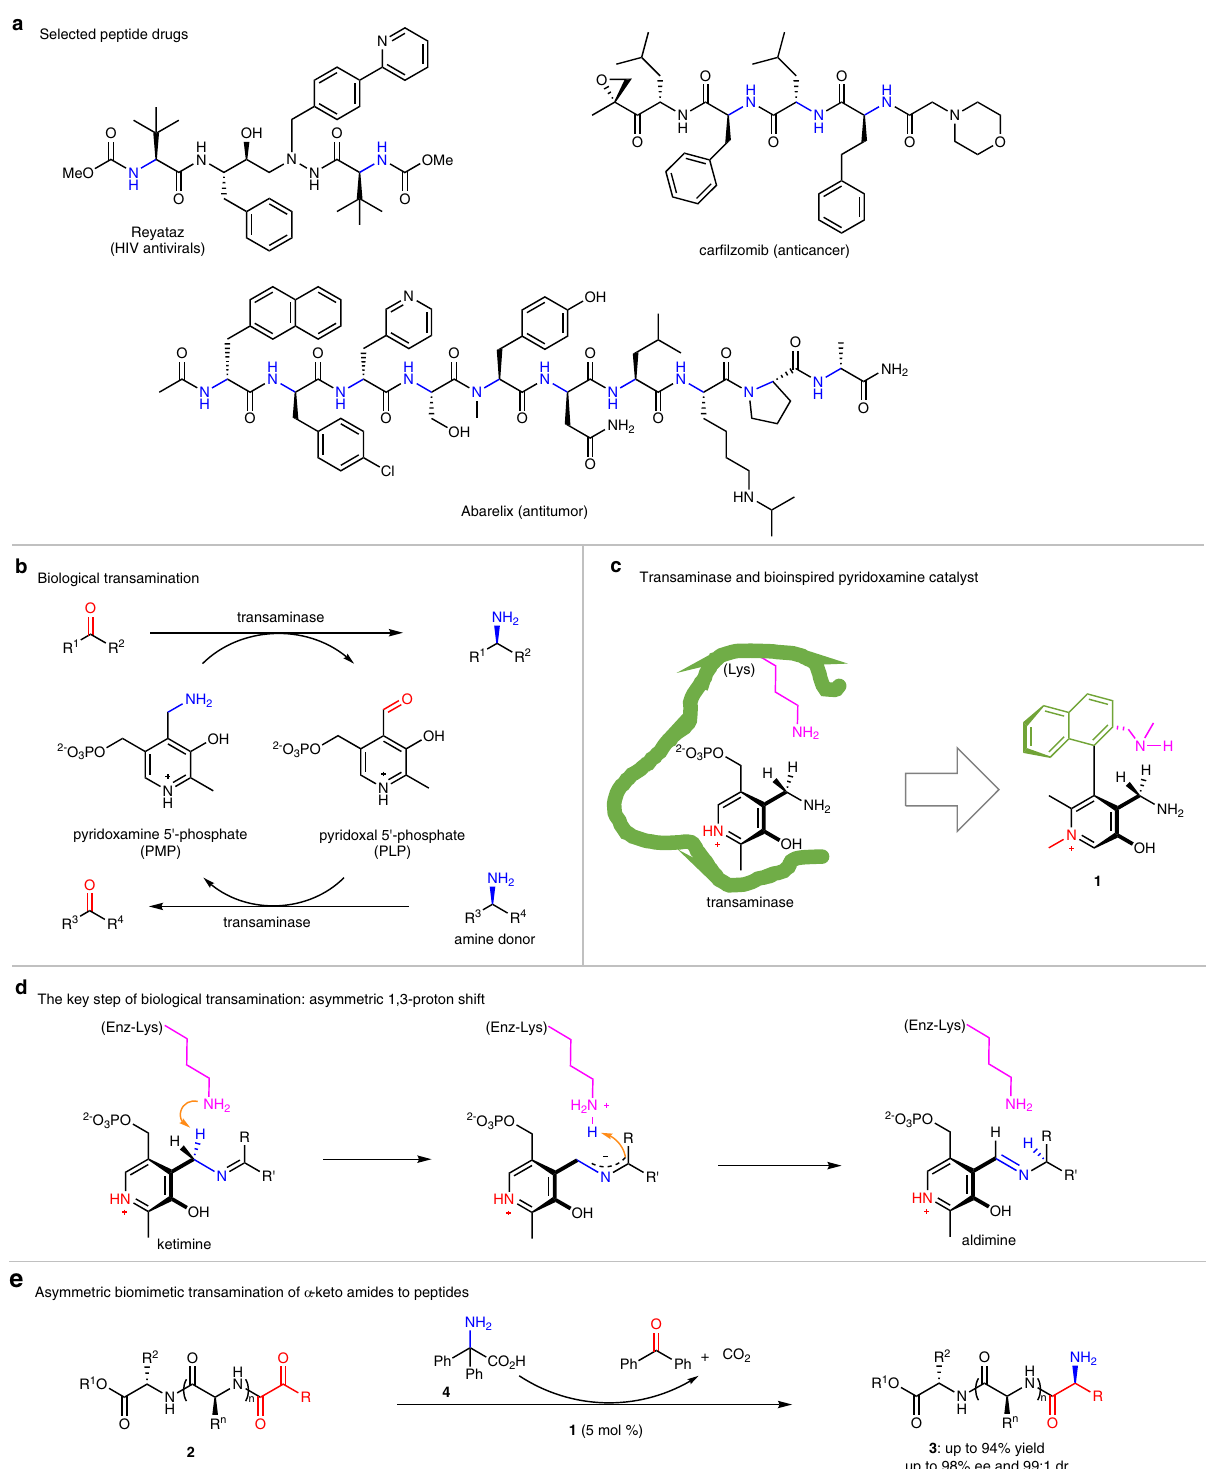
Fig. 1 Peptides and transamination. a Peptide drugs. b Biological transamination. c Catalyst design. d 1,3-Proton shift. e Transamination of α -keto